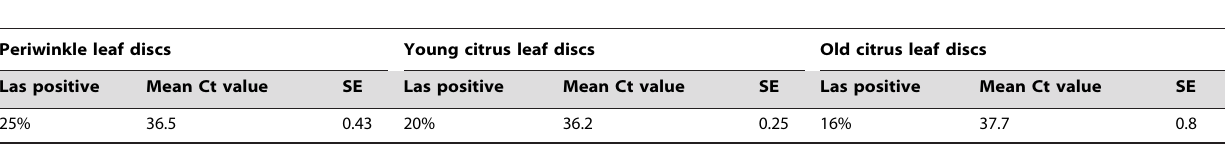
Table 1. Ct value of ‘ Candidatus Liberibacter asiaticus’ (Las) in host plant leaf discs after inoculation with individual adult Ferrisia virgate .